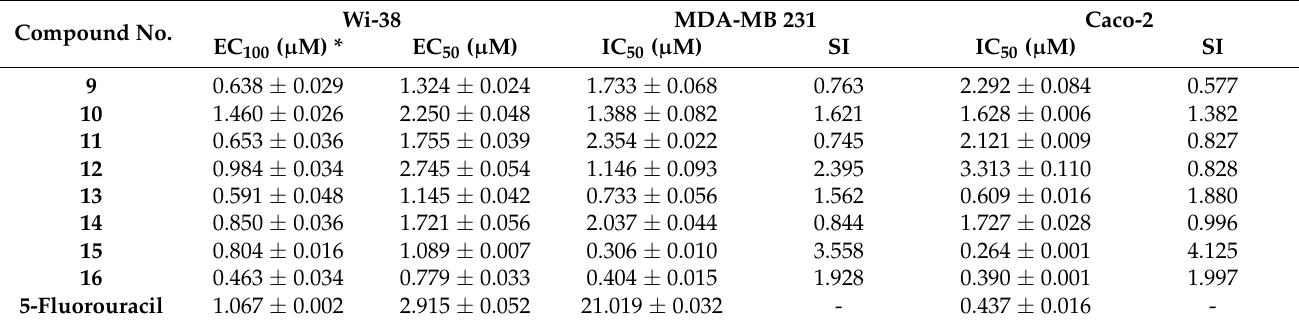
Table 2. Cytotoxicity and selectivity index (SI) values of the Mannich bases 9 – 16.